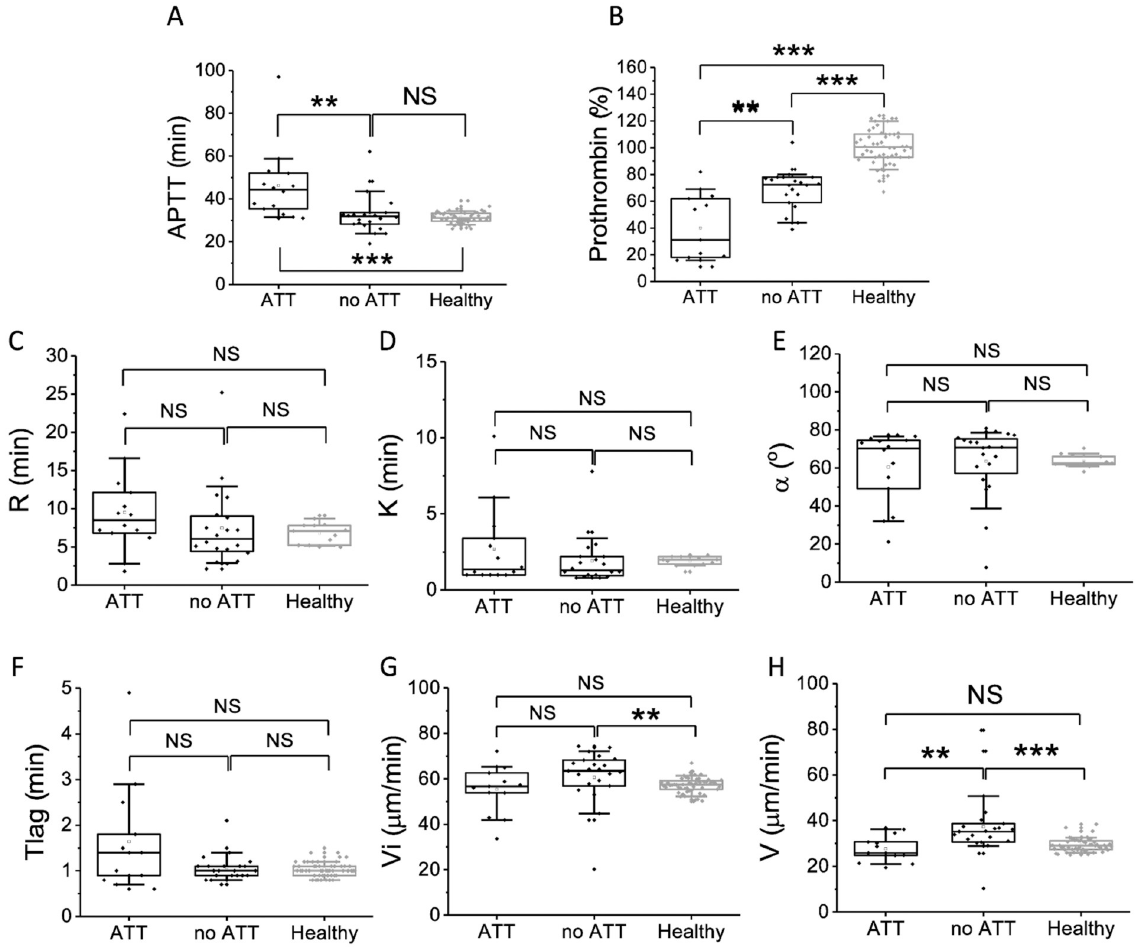
Fig 5. Coagulation parameters in patients receiving and not receiving antithrombotic (ATT) therapy at admission (with anticoagulants or antiplatelet agents). A—APTT (min), B—Prothrombin (%), C—R in TEG (min); D—K in TEG (min), E— α in TEG (min), F—Tlag in thrombodynamics (min), G—Vi in thrombodynamics ( μ m/min), H—V in thrombodynamics ( μ m/min). The box plots indicate the following parameters: the mean value (the dot inside the box), the median (the horizontal line inside the box), the 25 th and 75 th percentiles (the bottom and top of the box, respectively) and 5 th and 95 th percentiles (the ends of the whiskers). Groups were compared according to Mann-Whitney test; � p < 0.05, �� p < 0.01, ��� p < 0.001, NS—not